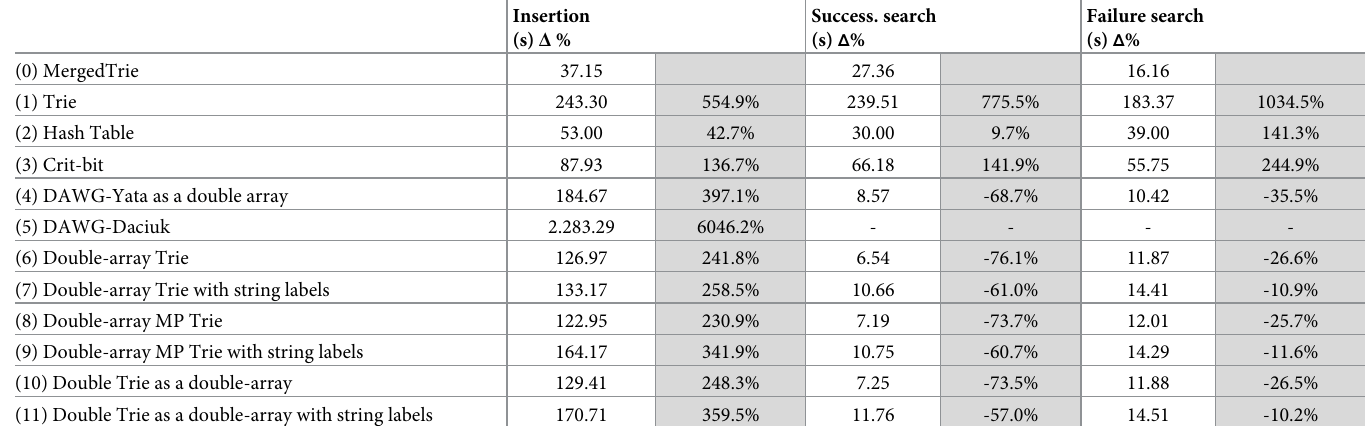
Table 4. Times in seconds in experiment 2 with Google1Grams corpora (58,654,411